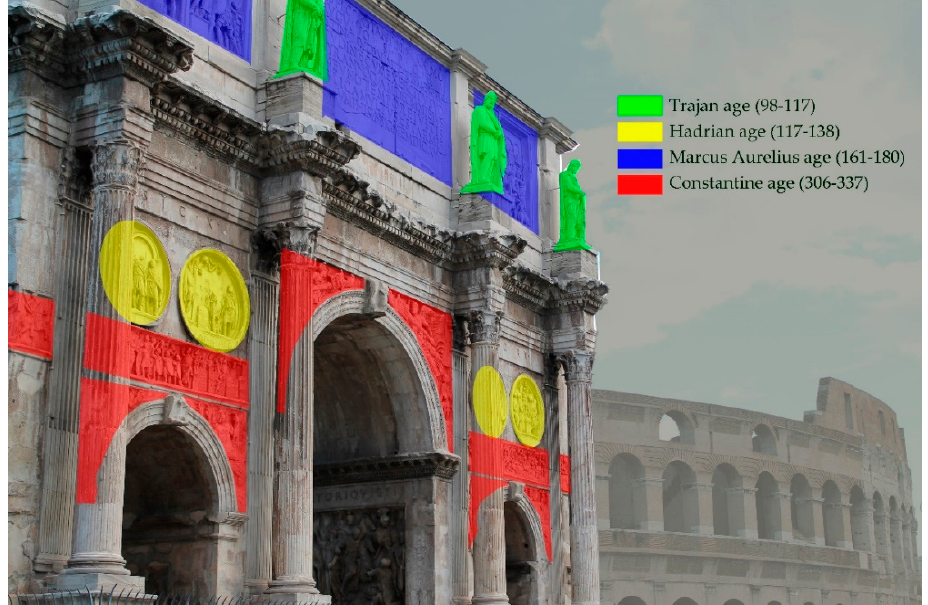
Figure 1. The reliefs of the arch of Constantine, reused from buildings of previous emperors (picture of Sara Torda from Picabay, drawings of G.B.).